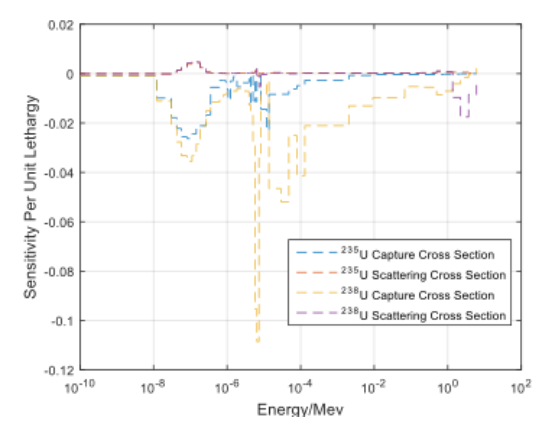
Figure 6. The sensitivity per unit lethargy of k to the 235 U and 238 U capture and scattering cross